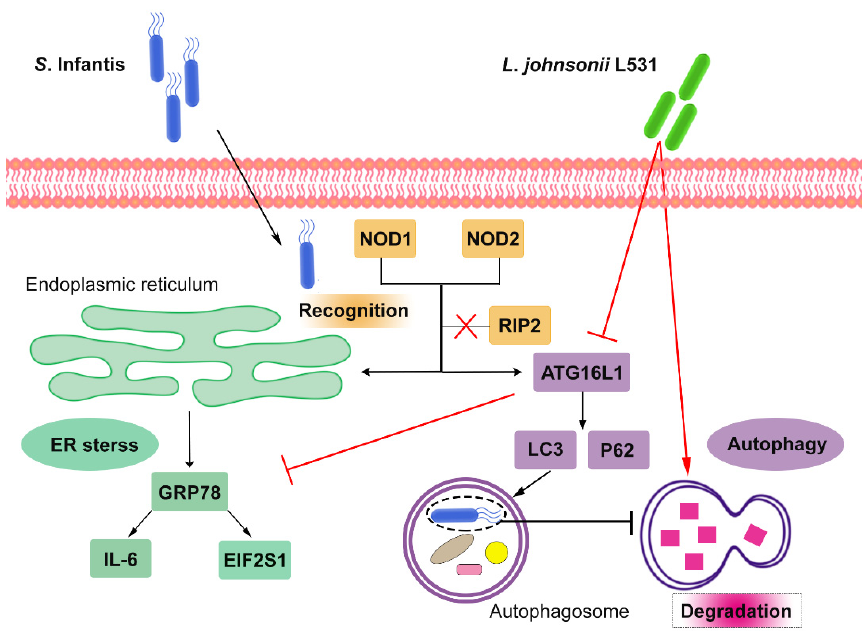
Figure 7. L. johnsonii L531 protects the intestine and Caco2 cells from S . Infantis infection by alleviating ER stress and promoting autophagy degradation. During S . Infantis infection, RIP2 inhibition did not impact the ER stress and autophagy.